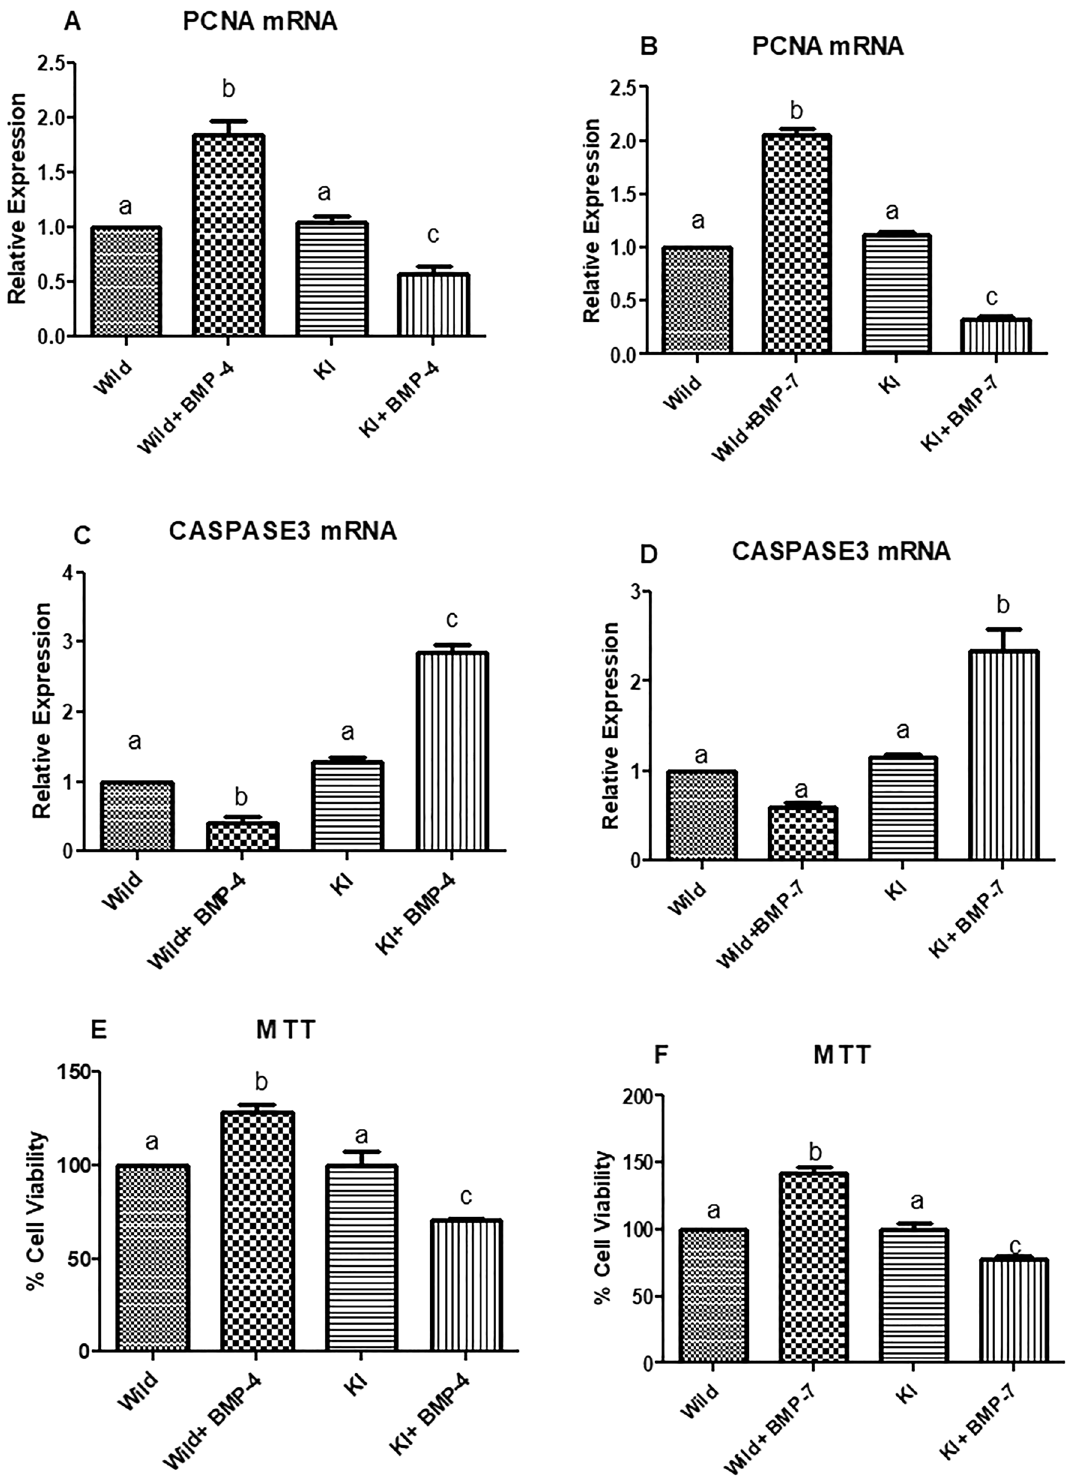
Figure 9. Effect of BMPR-IB gene KI on expression pattern of PCNA, Capase3 genes and cell viability of in vitro cultured granulosa cells stimulated with BMP-4 (50 ng/ml) or BMP-7 (100 ng/ml) for 72 h. All values are shown as mean ± SEM. Different superscripts denote statistically different values ( p < 0.05). Abbreviations: WT indicate wild type cells, WT + BMP-4/BMP-7 indicate wild cells treated with BMP-4 (50 ng/mL), KI indicate BMPR-IB gene knock out cells. KI + BMP-4/BMP-7 indicate KI cells treated with BMP-4(50 ng/ml) or BMP-7 (100